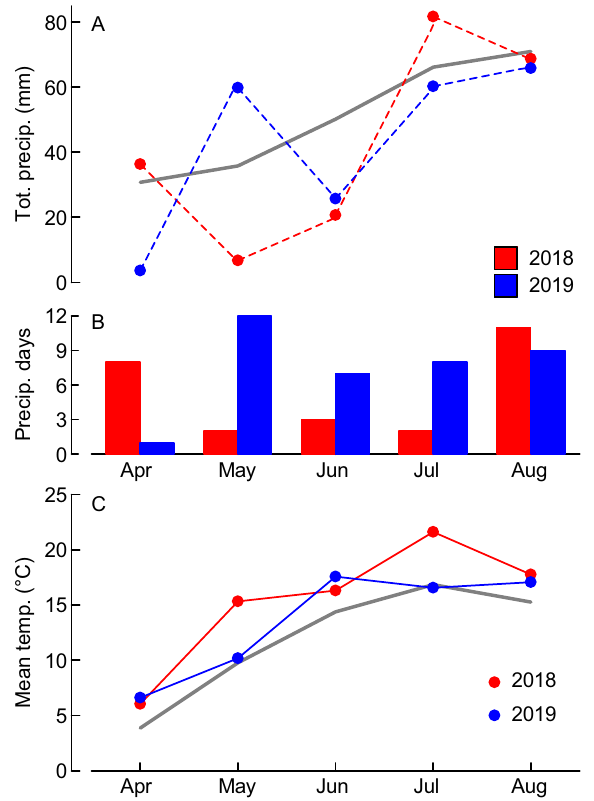
Figure 1. Weather conditions during the experimental periods of the years 2018 and 2019. ( A ) Total monthly precipitation, ( B ) number of days with precipitation ≥ 1 mm, and ( C ) mean air temperature. Long-term (1896– 2019) means (solid gray lines) are plotted for comparison. All data were collected at the Ultuna climate station near Uppsala, situated 3 km south-west from the experimental site.